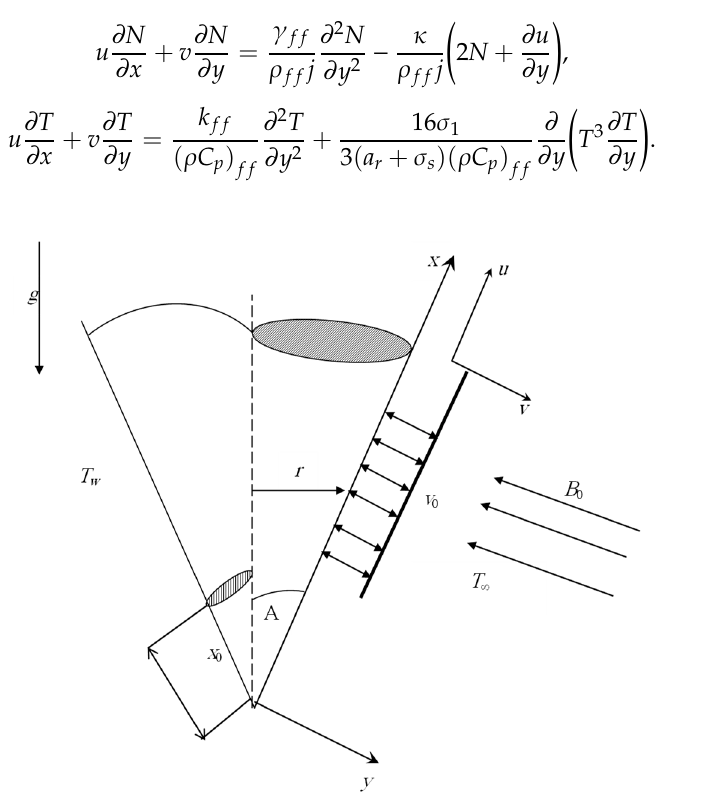
Figure 1. Problem Schematics and Coordinate System.